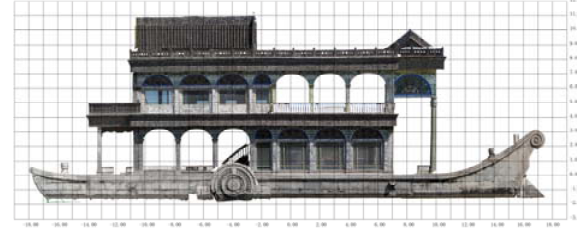
Fig.13. The Orthophoto of Stone Boat [ 石舫 ] , 2012